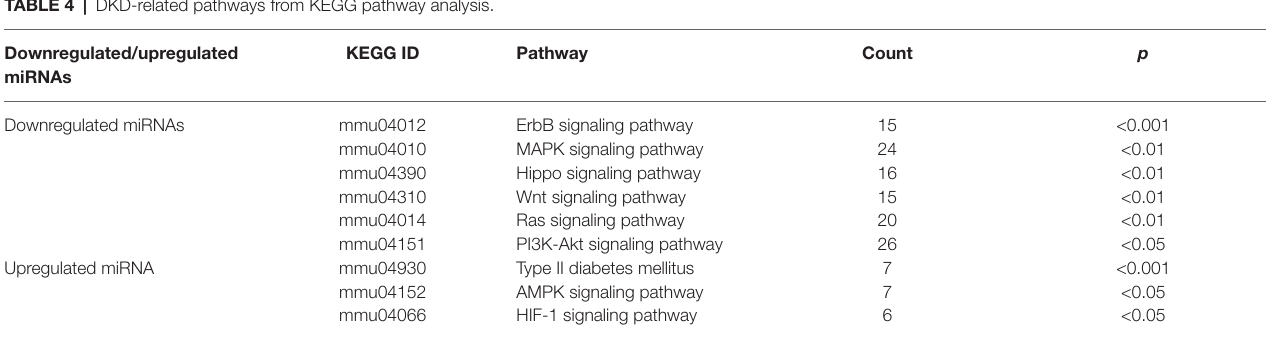
TABLE 4 | DKD-related pathways from KEGG pathway